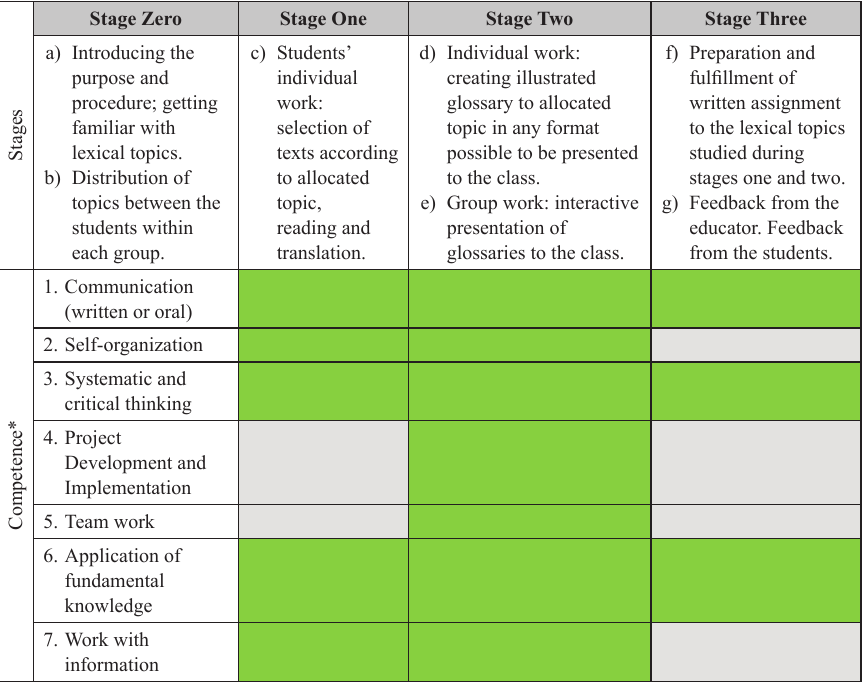
Table 1. Model of the enhanced lexical aspect acquisition distributed in